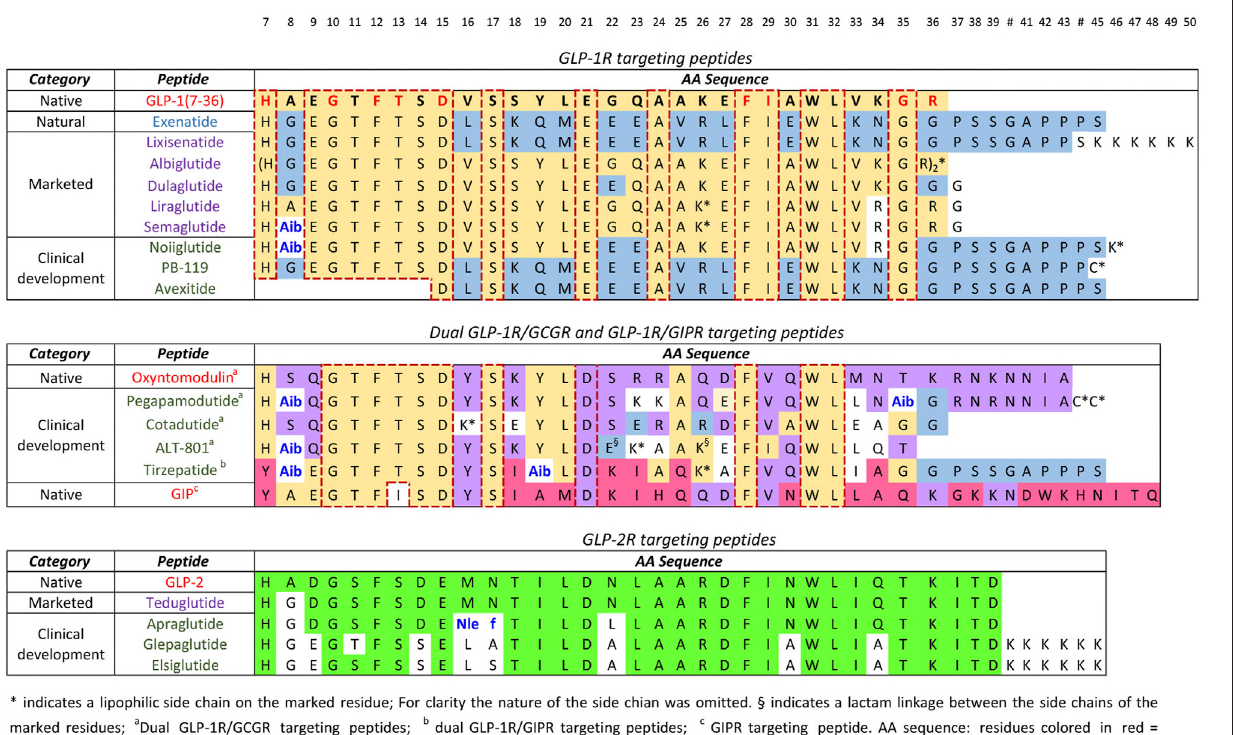
FIGURE 7 | Alignment of analogue peptides with the corresponding native ones in T2DM/obesity and SBS